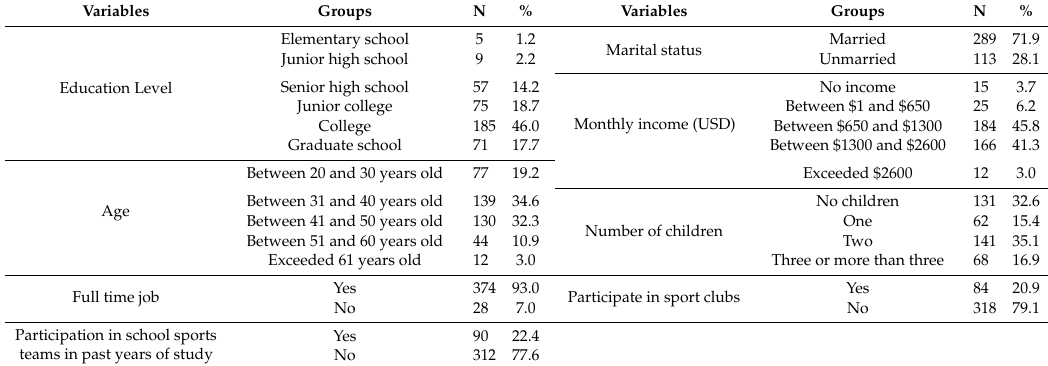
Table 1. Description of the demographic variables of the